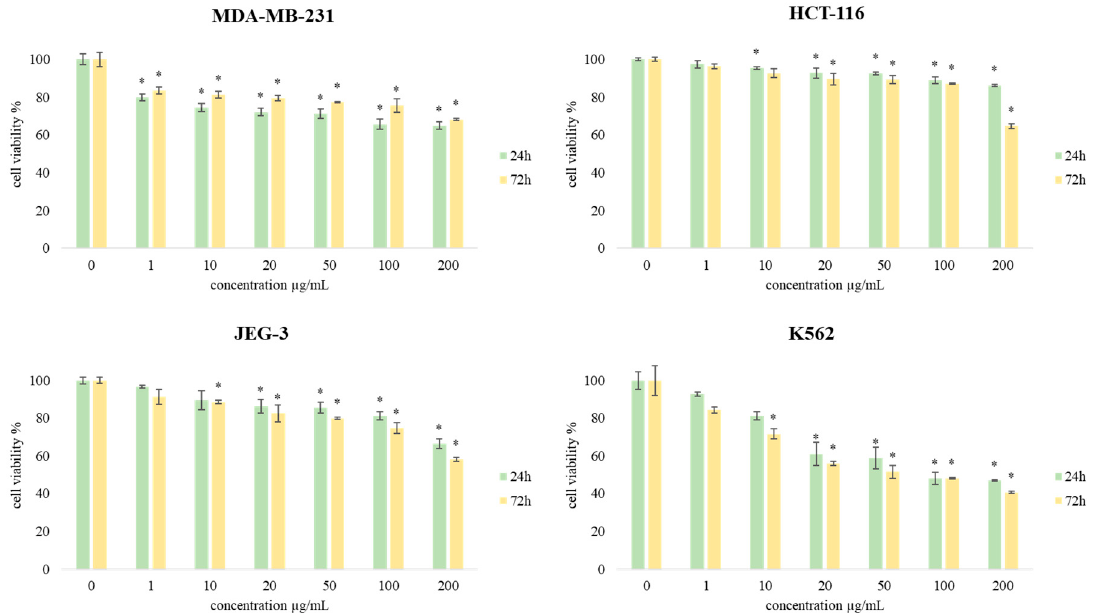
Figure 4. The effects of six concentrations of CSEO on MDA-MB-231, HCT-116, JEG-3, and K562 cell viability after 24 h and 72 h of treatment. Results are presented as the mean of three independent experiments ± standard error: * p < 0.05 relative to control.